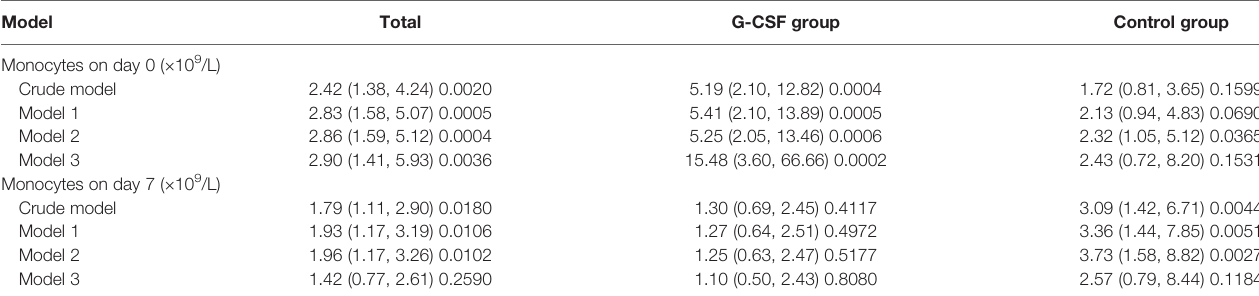
TABLE 2 | Association between monocyte count and 180-day mortality in HBV-ACLF patients. Model